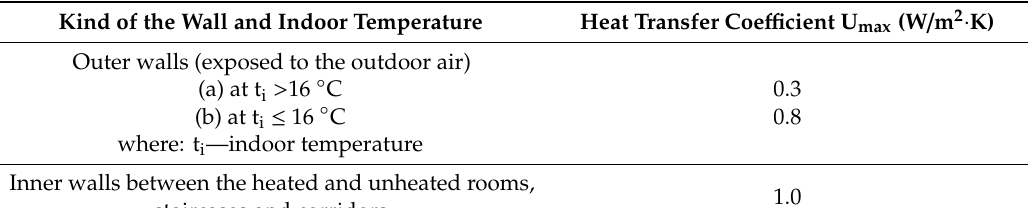
Table 2. The values of the heat transfer coe ffi cient U (W / m 2 · K) for the walls of the residential buildings, determined for weather conditions in Poland (according to Ministerial Order §134 art. 2).